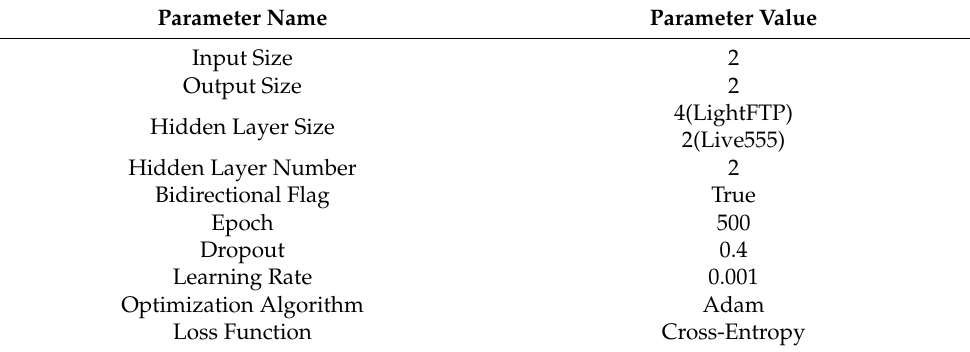
Table 4. The parameter settings of the test case filter.